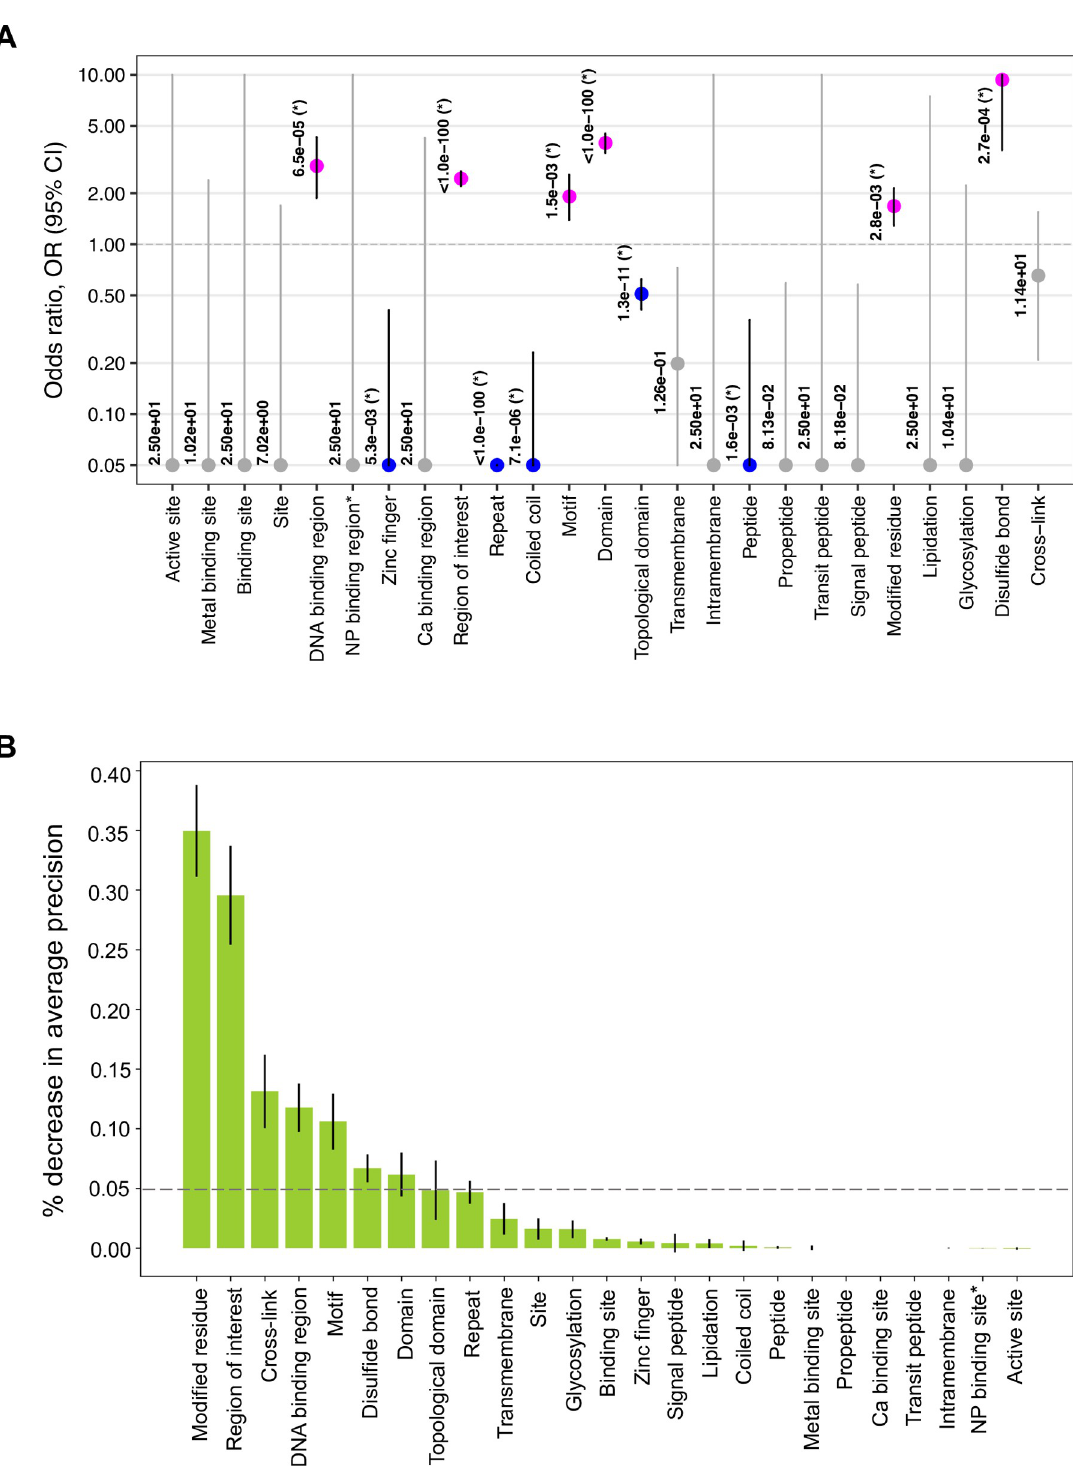
Fig 5. Mutation-intolerant IDRs carry characteristic UniProt features compared to relatively tolerant IDRs. ( A ) Results of association (two-tailed Fisher’s Exact test) between different UniProt features (x-axis) and residues of mutation-intolerant and tolerant IDRs (Fig 4A). Circles show the odds ratios (ORs) and are labelled with the corrected p-values ( q ), showing the significance of the association (a value of q < 1.0e-100 indicates the maximum significance, see Materials and Methods ). Vertical bars show the 95% confidence interval (CI). OR > 1.0 and OR < 1.0, along with q < 0.05, indicate that the feature is associated with the